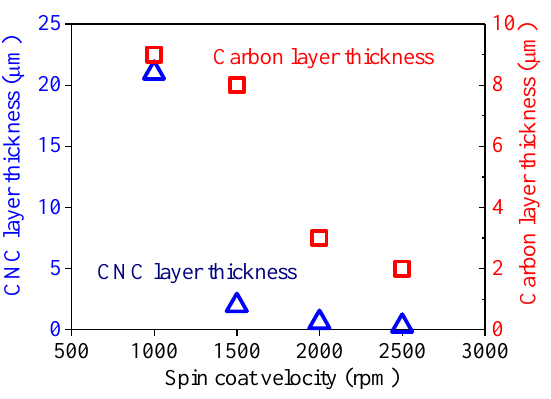
Figure 6. Thicknesses of CNC and carbon layers vs. spin-coat velocity. The synthesis time was 10 min.